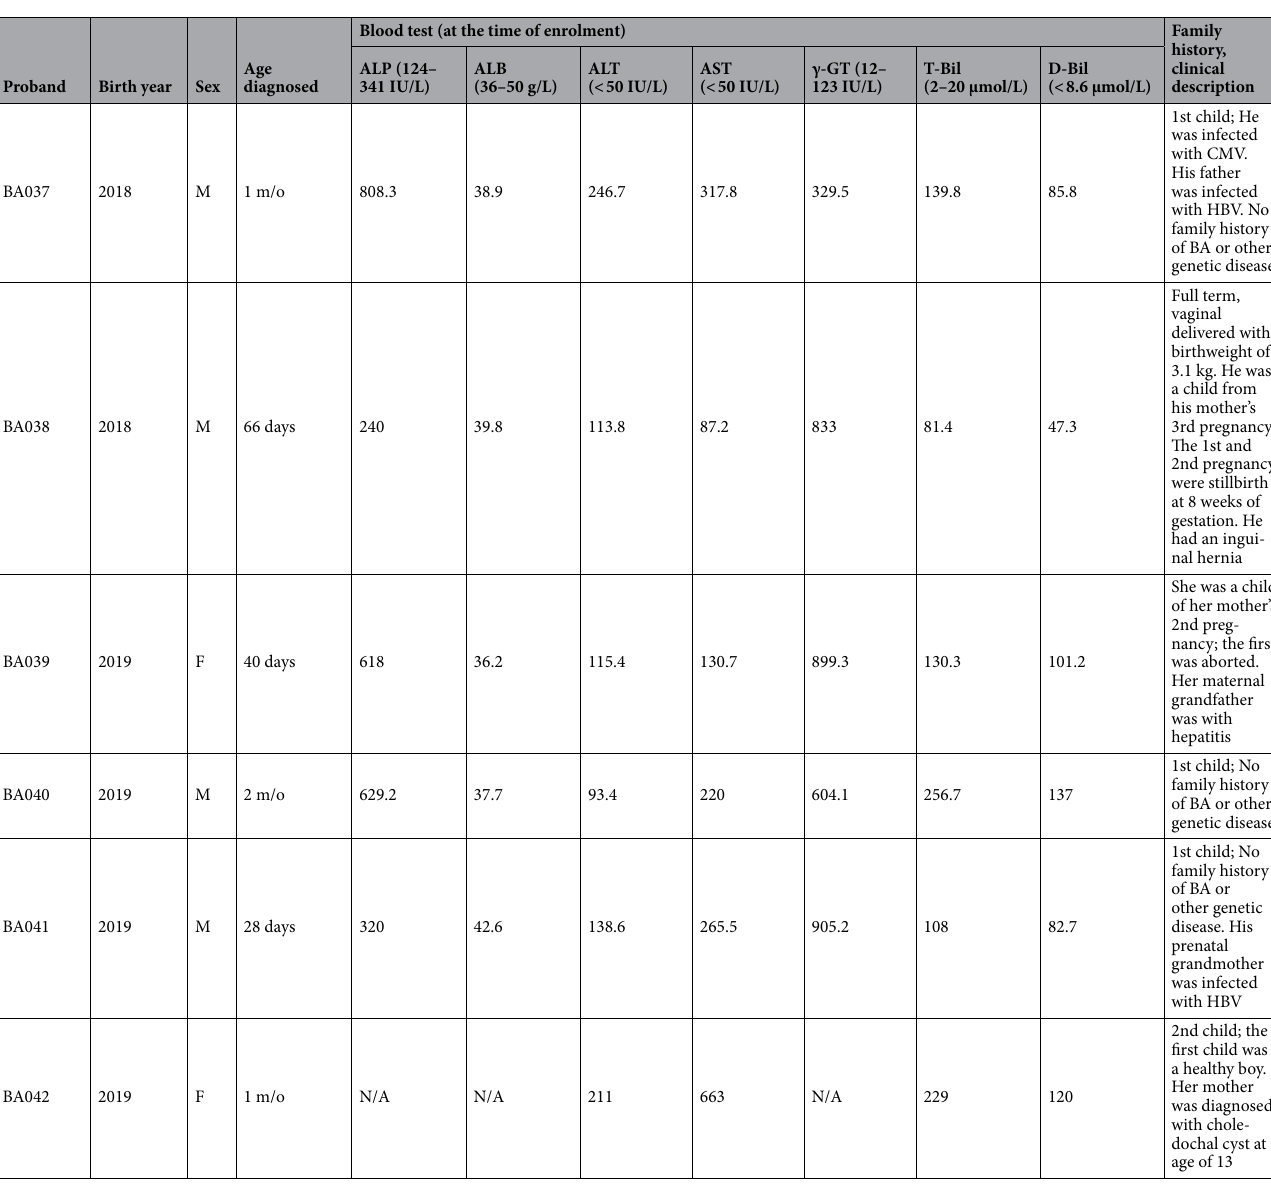
Table 1. Clinical features of children with biliary atresia. M male, F female, m/o month old, ALP alkaline phosphatase, ALB albumin, ALT alanine aminotransferase, AST aspartate aminotransferase, γ-GT